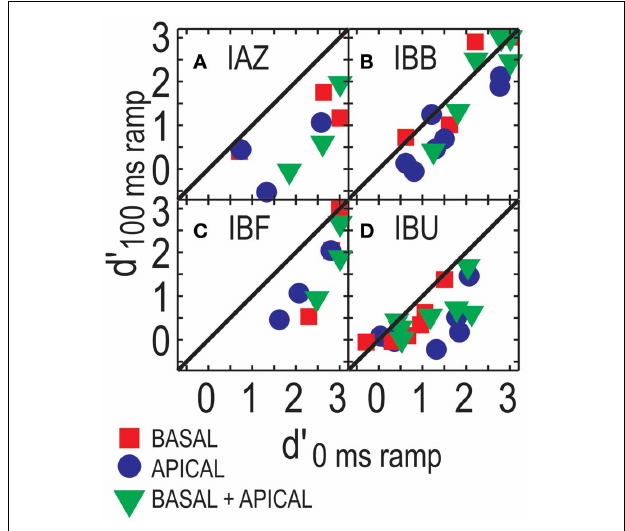
FIGURE 4 | ITD sensitivity for stimuli with and without ramp, from Experiment 1 and 2, respectively. Each panel (A–D) shows results for one listener. Basal-only, apical-only, and dual-site electrode configurations are shown by the different symbols. Repeated symbols reflect the fact that performance is shown across a range of modulation